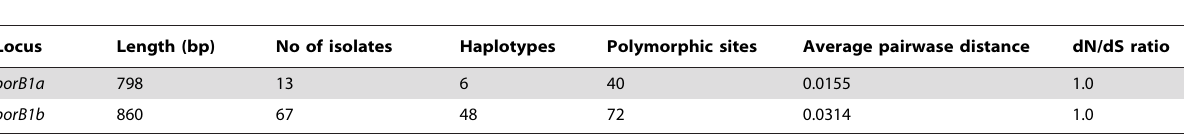
Table 3. Genetic characteristics of porB nucleotide sequences for gonococcal isolates.